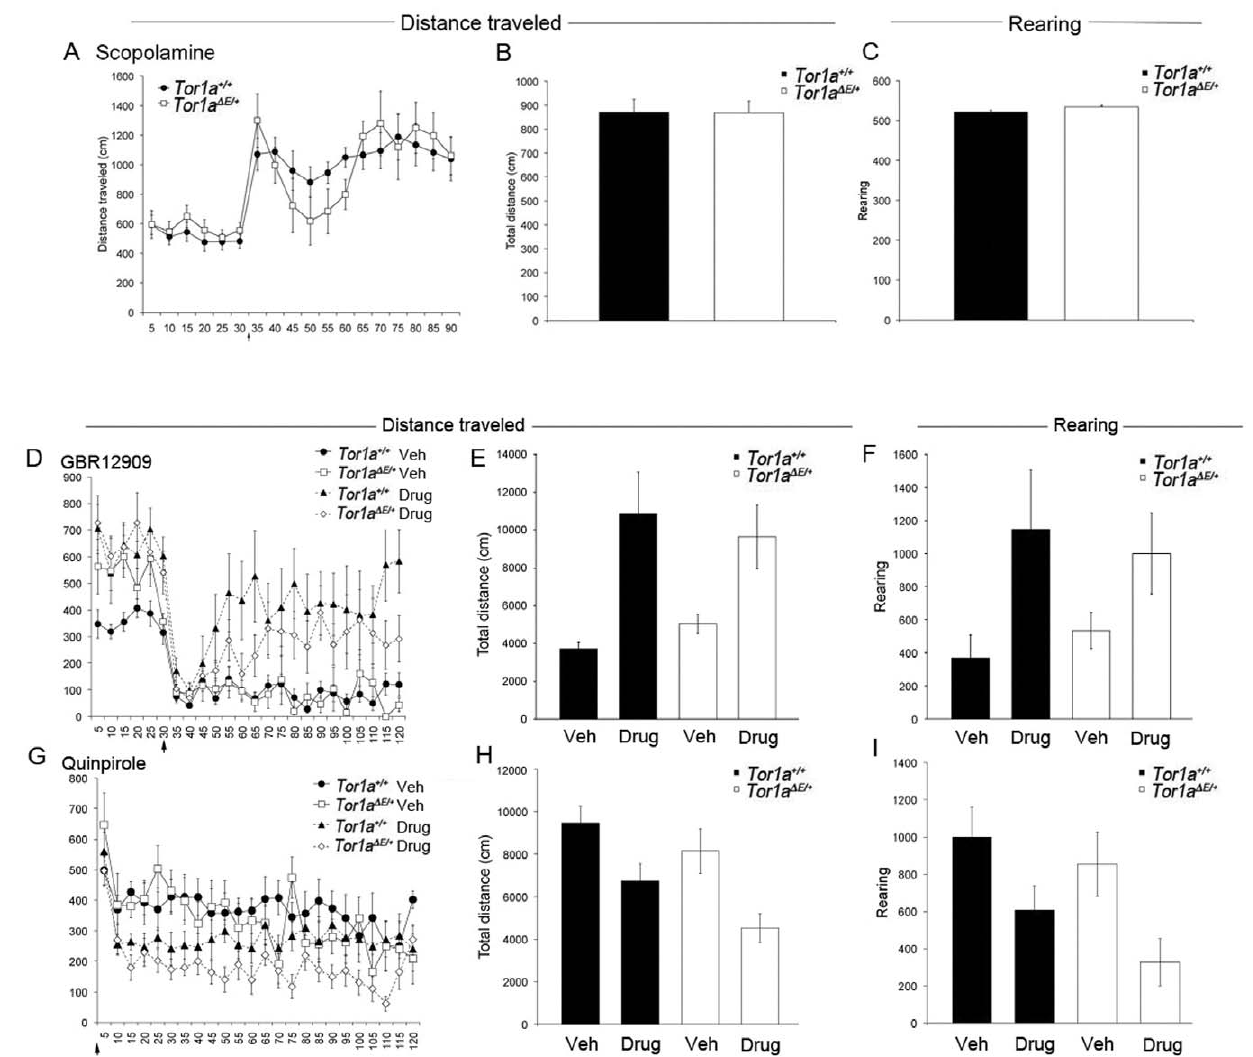
Figure 3. B6 ? Tor1a D E/ + mice do not respond differently to pharmacological challenges in the open-field. Locomotor activity of B6 ? Tor1a D E/ + and B6 ? Tor1a + / + mice was monitored for 90 minutes (5 min per point) total. After a 30 minute habituation period, mice were injected with (A) scopolamine (1.0 mg/kg) or (D) GBR12909 (5.0 mg/kg) or vehicle (indicated by arrow) and monitored for an additional 60 minutes. Scopolamine and GBR12909 stimulated locomotor activity of both genotypes but there was no interaction between genotype and drug. Scopolamine challenge, rm-ANOVA reveals no main effect of genotype and no significant interaction between time and genotype (F[2.52, 55.35]=1.05, p=0.37) of horizonal activity in the openfield (A). When totaled over the entire time in the openfield, there is no significant effect of genotype on total horizontal distance, t[22]=0.040, (p=0.97) or total rearing t[22)]= 2 0.143, (p=0.86; B–C). GBR challenge, rm-ANOVA demonstrated a significant main effect of drug, F[1,25]=7.39, p=0.01, but no significant main effect of genotype (F[1,25]=.287, p=0.60) and no significant interaction between drug and genotype (F[1,25]=0.08, p=0.78; D). Evaluation of total horizontal distance and total rearing with two-way ANOVA finds significant main effect of drug (F([1,20]=16.02, p=0.00 (total horizontal distance); F[1,21]=0.20, p=0.66 (total rearing)) but no interaction between drug and genotype (F[1,20]=1.46, p=0.24 (total horizontal distance); F[1,21]=0.50, p=0.49 (total rearing; E–F). (G) Quinpirole (0.1 mg/kg) was injected at the start of the open field session and locomotor activity was monitored for 120 minutes. Quinpirole inhibited locomotor activity of both groups of mice compared to vehicle but did not elicit a significant difference between genotypes. Rm-anova demonstrated a significant main effect of drug F[1,29]=13.65, p=0.001, a significant main effect of genotype (F[1,29]=0.28, p=0.05), but no significant interaction between drug and genotype (F[1,29]=0.28, p=0.06). (H–I) Examination of total horizontal distance and total rearing with two-way ANOVA finds a significant main effect of drug (F[1,30]=11.330, p=0.002 (total horizontal distance); F[1,30]=9.68, p=0.004 (total rearing)) but no interaction between drug and genotype (F[1,30]=0.74. p=0.40 (total horizontal distance); F[1,30]=0.20, p=0.66 (total rearing). doi:10.1371/journal.pone.0032245.g003 mutation in the heterozygous animals. We generated congenic B6 ? Tor1a D E/ + mice and tested them in several behavior paradigms: open field (with and without pharmacological challenge), rotarod, and balance beam. Similar to the 129S6/SvEvTac background, however, there were no significant differences between Tor1a D E/ + and Tor1a + / + on the B6 background. utes of the open field test, (p= 0.05). Dang et. al. also measured